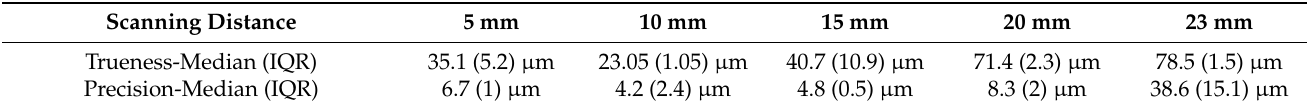
Table 1. Median values for trueness and precision data.